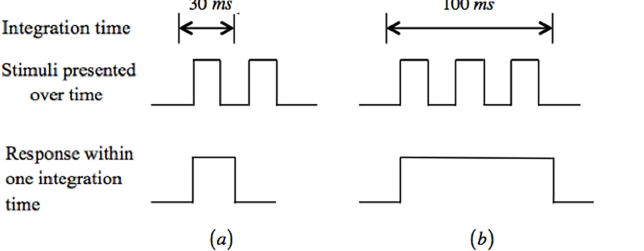
Fig 3. Varying integration times. (a) For a short integration time, flashes can be detected. (b) For a longer integration time, no flashes are perceived. Instead, only one long coherent flash is detected.